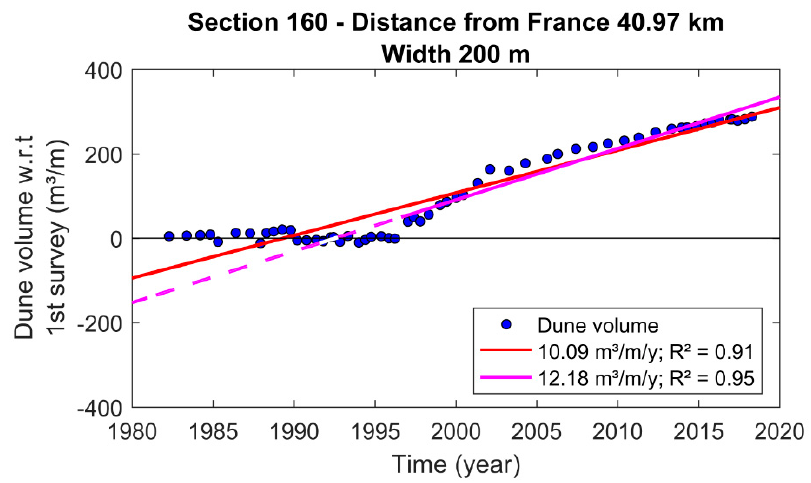
Figure 18. Decadal dune evolution of the coastal dunes at section 160. The solid magenta line indicates the recent dune trend.